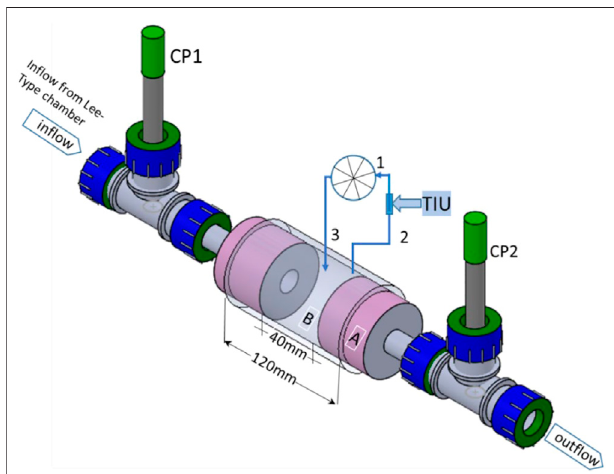
FIGURE 3 | Flow-through unit equipped with conductivity probes CP1 andCP2atthein fl owandout fl owoftheFTU.ThewatervolumeinsidetheFTU is continuously mixed by the circulation pump (1). The TIU (2) injects the saline tracer into the mixing unit (3) to determine the MRT and quantify the fl uid discharge rate. The measuring range of the SGD-MRT is adjustable by sliding the Delrin end caps (A) inwards or outwards of the elastic PVC tube (B) .